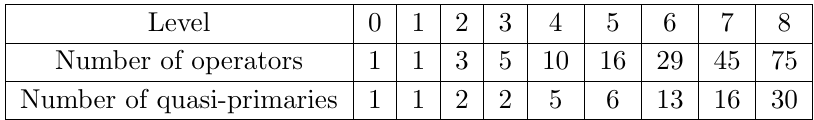
Table 1 . Numbers of (quasi-primary) operators at each level in the original